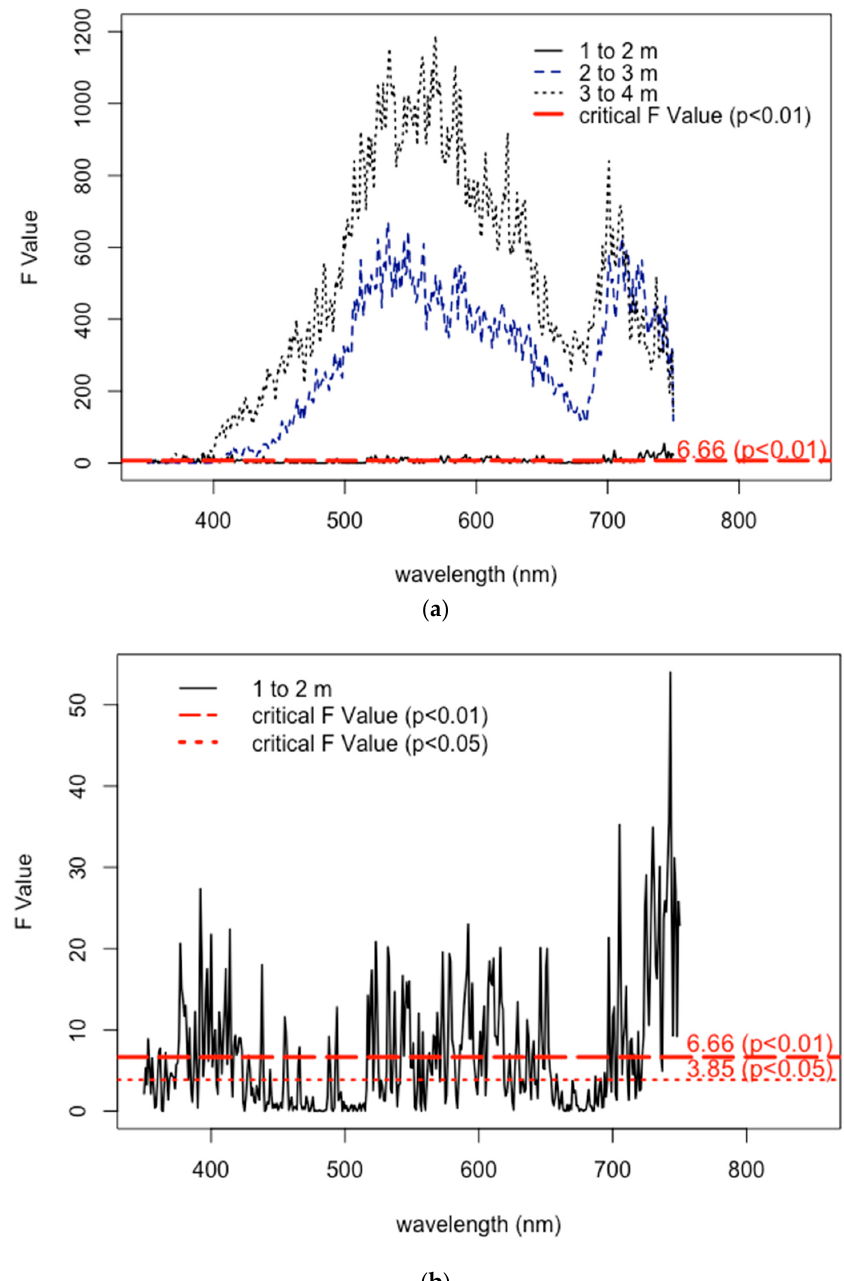
Figure 5. F-values of ANOVA for ( a ) varying natural growing depths; and ( b ) insets for a growing depth of 1–2 m.